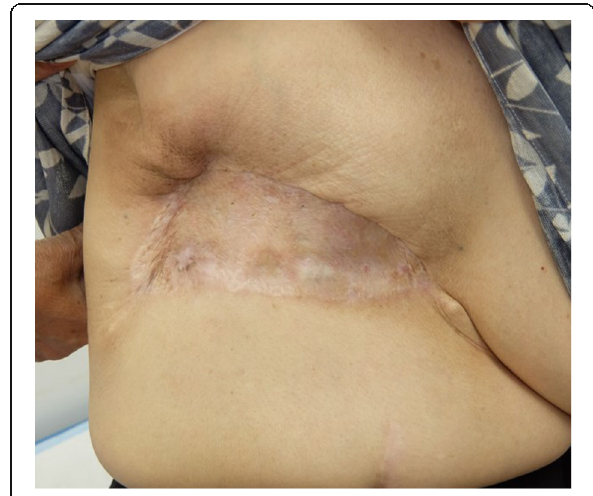
Fig. 4 After the operation. The patient has not suffered an RAAS relapse in the last 3